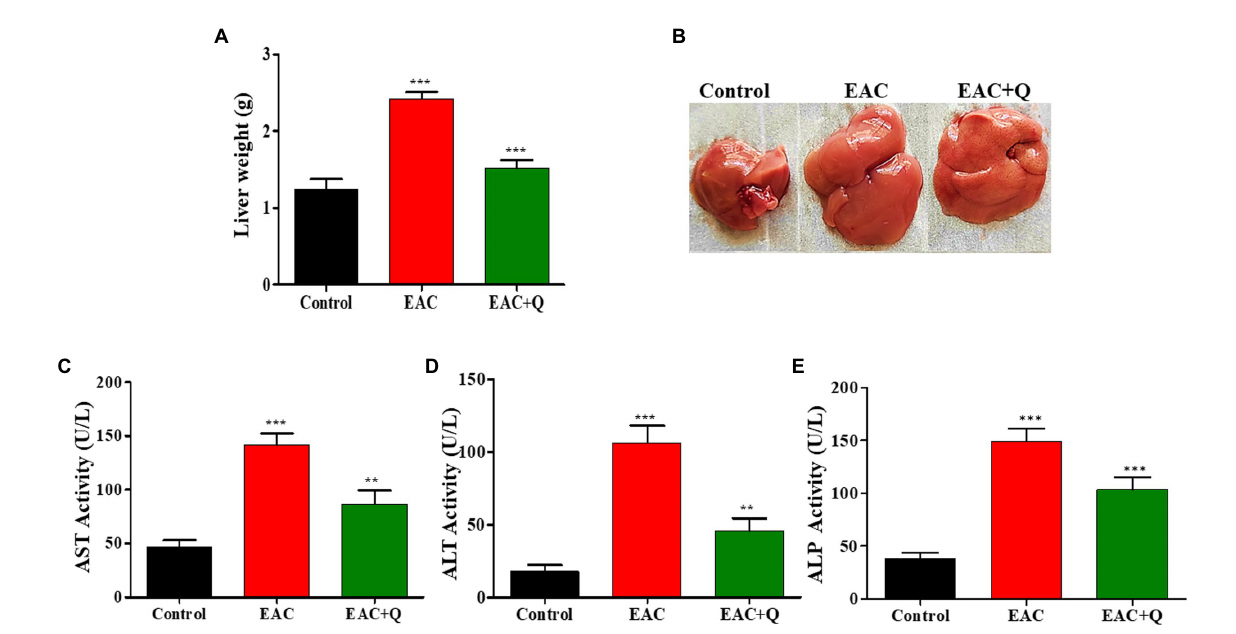
FIGURE 2 Quercetin ameliorates EAC tumor cells induced hepatitis. (A) Bar graph representing the decrease in liver weight of quercetin treated EAC mice compare to control EAC bearing mice ( n = 5/group). (B) Representative images showing the decreased liver weight in quercetin treatment group ( n = 5/ group). (C–E) Bar graph showing the decrease in the serum AST, ALT, and ALP levels in quercetin treated EAC animals when compared to control EAC bearing animals ( n = 5/group). **, *** represents that p values less than 0.005 and 0.0005 respectively.